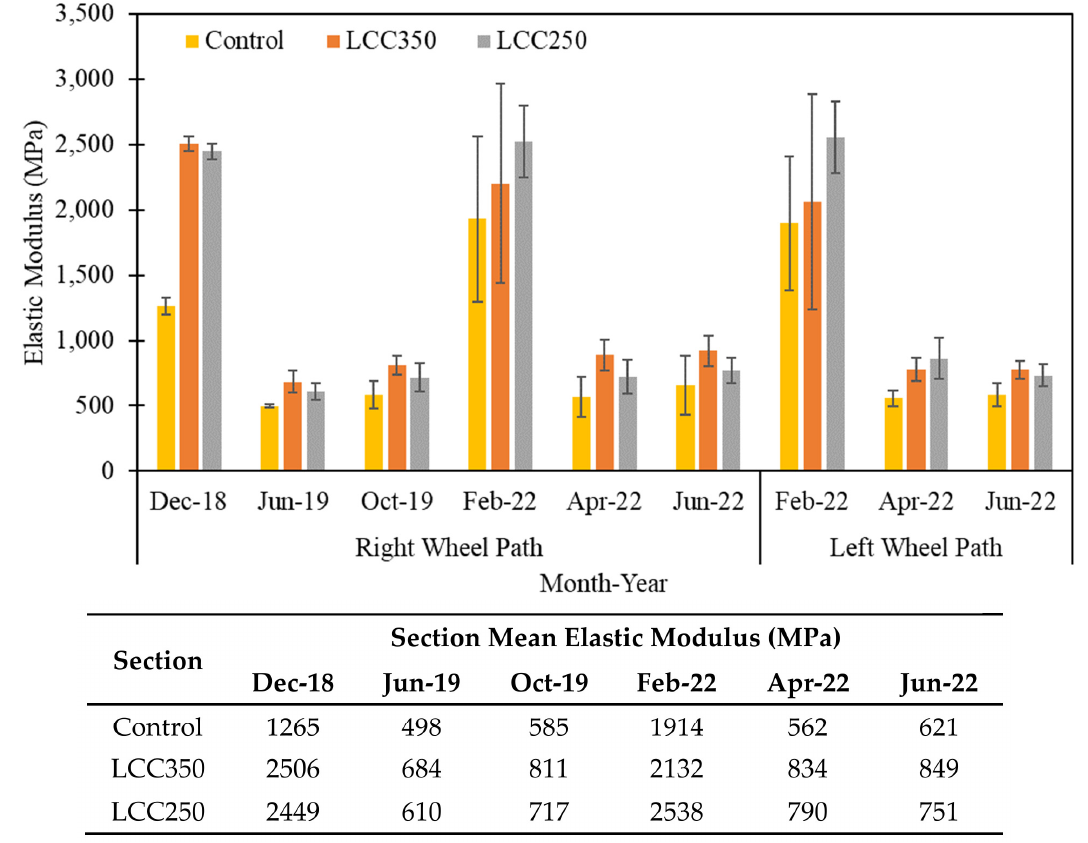
Figure 6. Erbsville LWD measured elastic modulus.